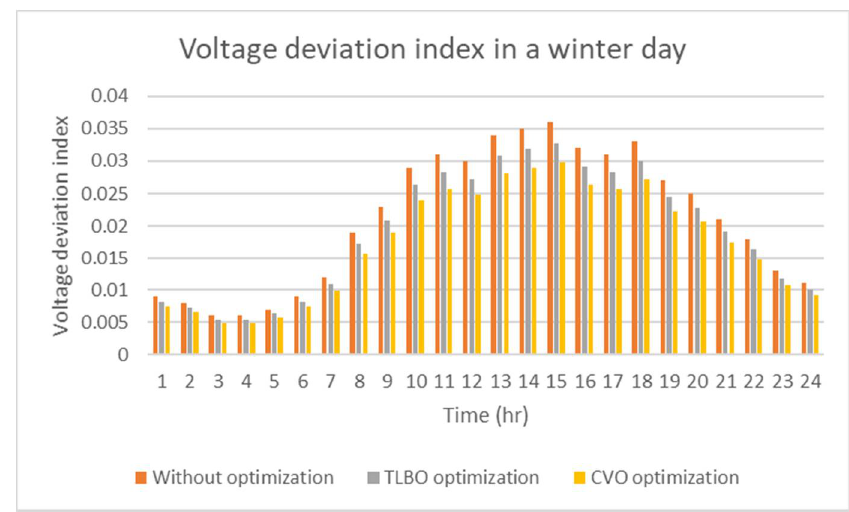
Figure 10. Total power losses and voltage deviation index in a winter day.